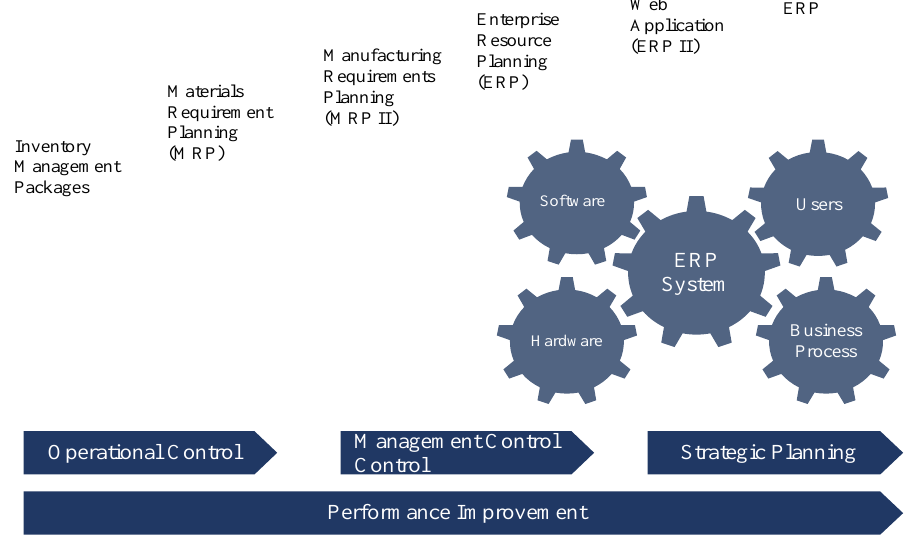
Figure 2. Evolution of ERP Systems.